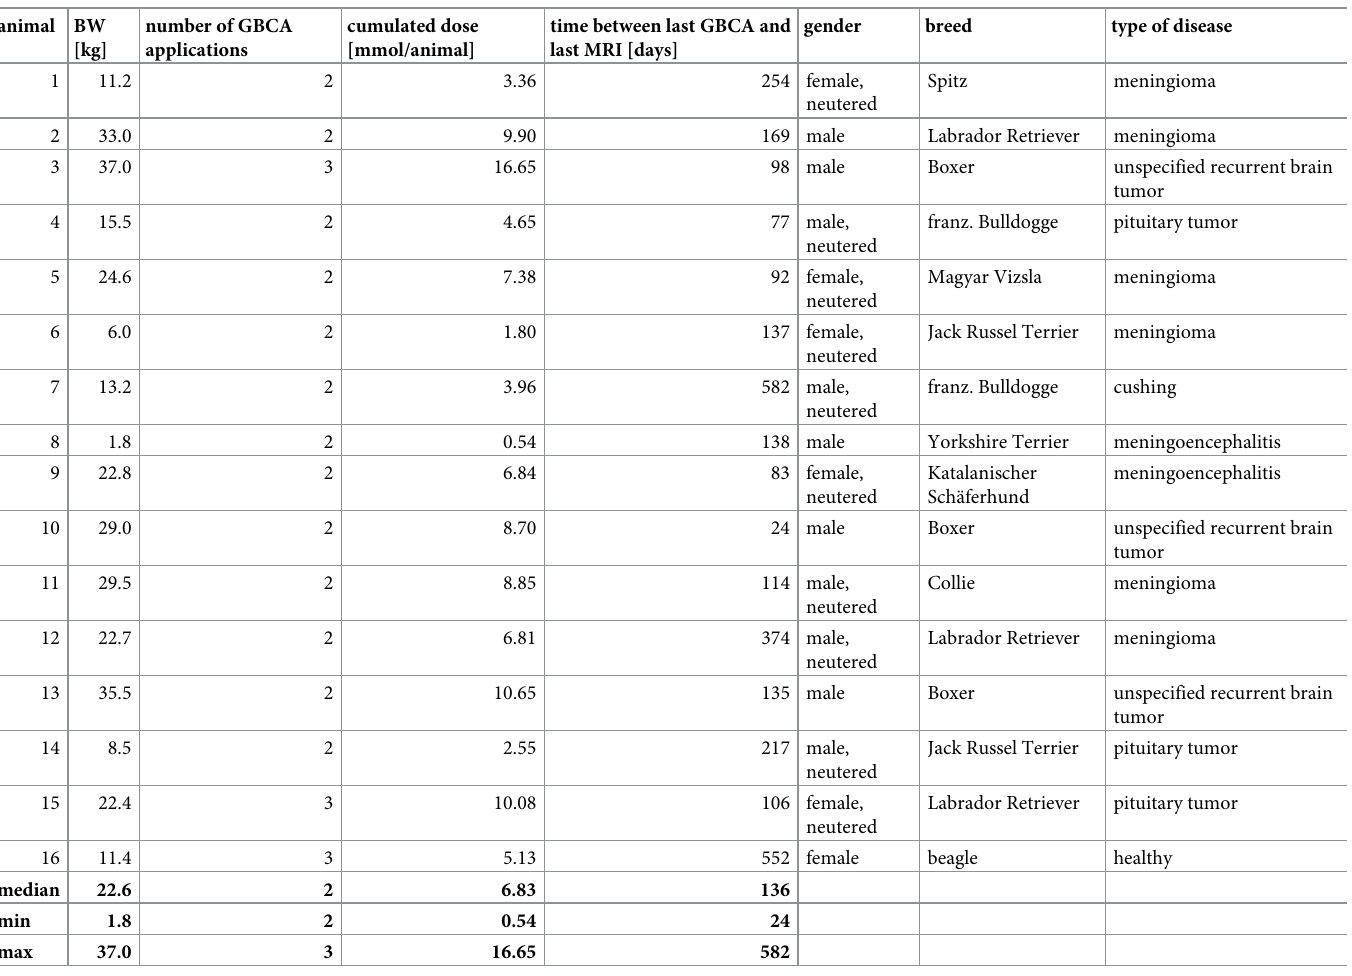
Table 1. Demographic and clinical